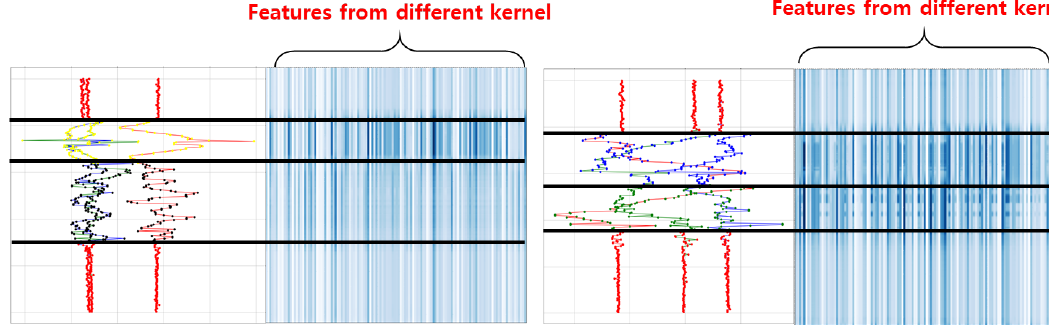
Figure 5. Examples of attention score in channel level.